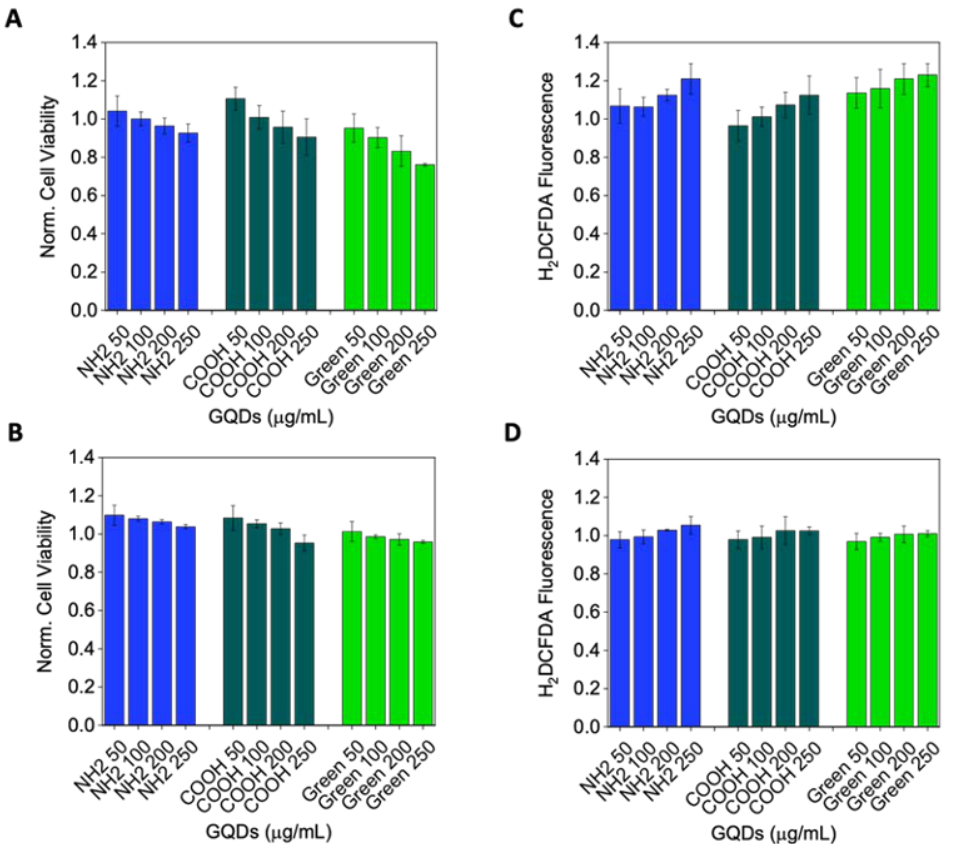
Figure 2. Toxicity of GQDs on U87 and cortical neurons after the treatment with GQDs. Cell viability normalized by control U87 untreated cells ( A ) and cortical neurons ( B ). Reactive oxygen species (ROS) production measured by fluorescence intensity of 2 ′ ,7 ′ -dichlorodihydrofluorescein diacetate (H 2 DCFDA) for U87 ( C ) and cortical neurons ( D ) normalized by control cells.